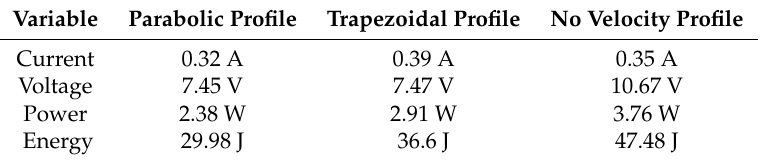
Table 7. Comparison of the average consumption in both profiles for 10